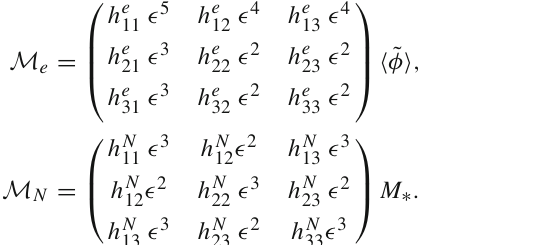
are expressed i